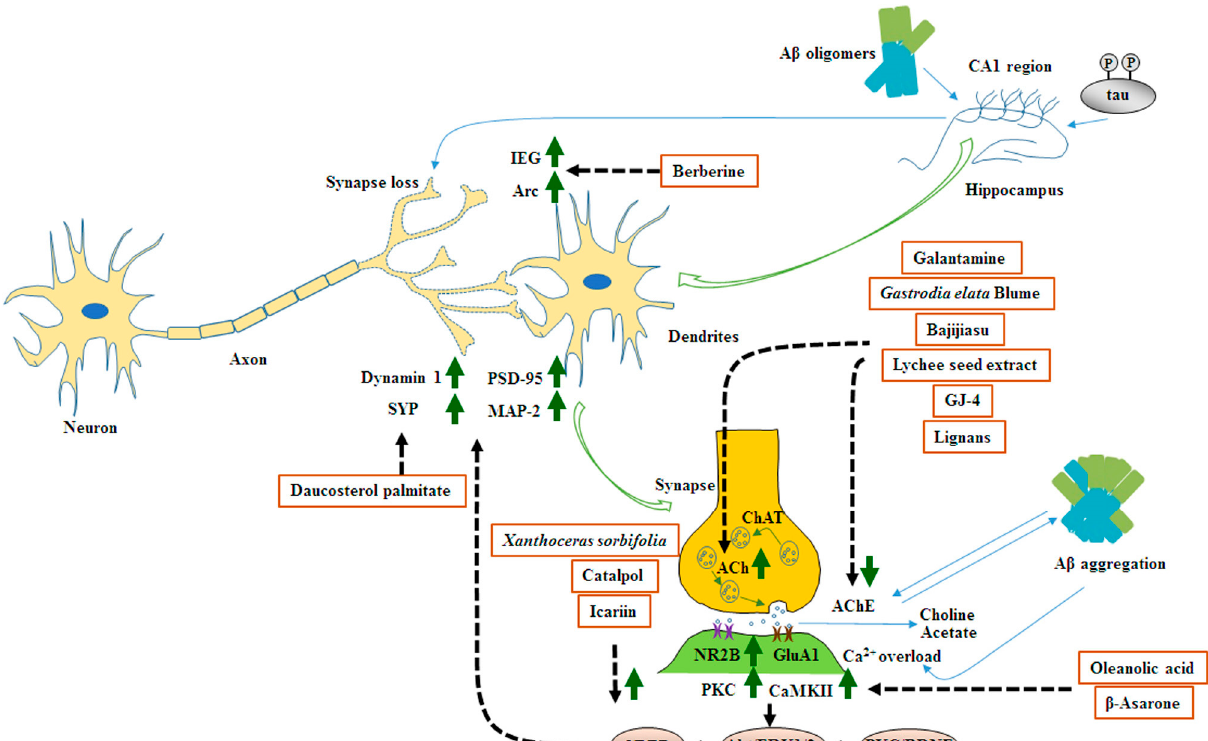
Figure 5. Schematic representation of the effects of MHDIs on A β -induced synaptic dysfunction in the hippocampus in the early and late phases of AD in in vivo models.